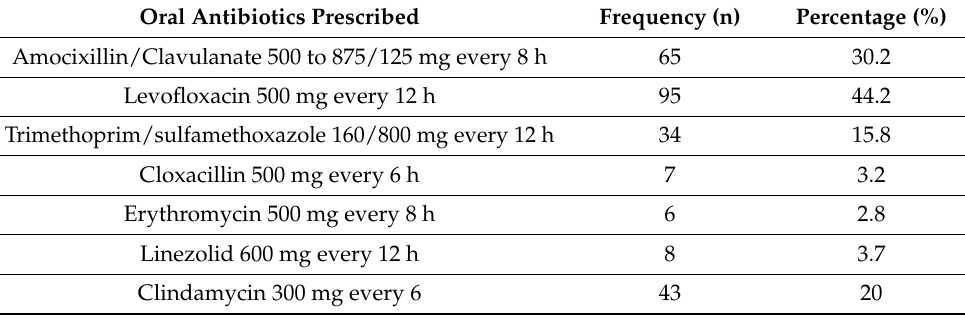
Table 5. Oral antibiotics